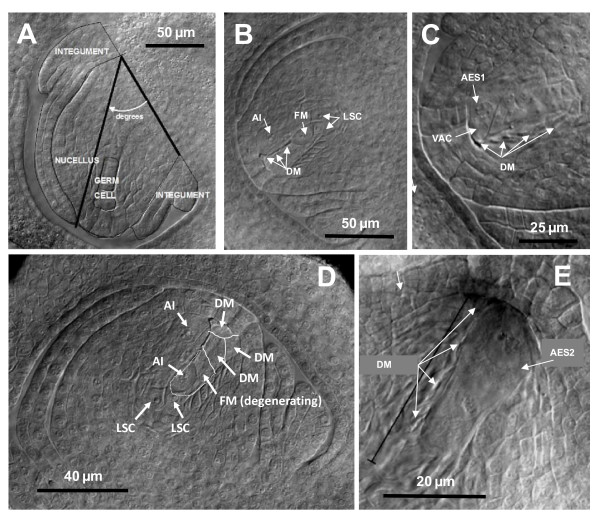
Differential interference contrast images of cleared Sorghum bicolor ovules in sagittal section. A) Procedure used to measure ovule area components (germ cell, nucellus and integuments), ovule curvature (angle), and inner integument length (distance from base to tip); from Carman [29], used with permission (caudatum, Agira, PI217855). B) Three degenerating megaspores (DM), the functional megaspore (FM), an aposporous initial (AI), and two large stack cells (LSC) (RIL, TX 37-6). C) Four DM and a vacuolate (VAC) 1-nucleate aposporous embryo sac (AES) (RIL, TX 152-6). D) Three DM, a degenerating FM, two AI, one of which is absorbing the FM, and two LSC (RIL, TX 4-7). E) Four DM and a 2-nucleate AES (breeding line, IS3620C).